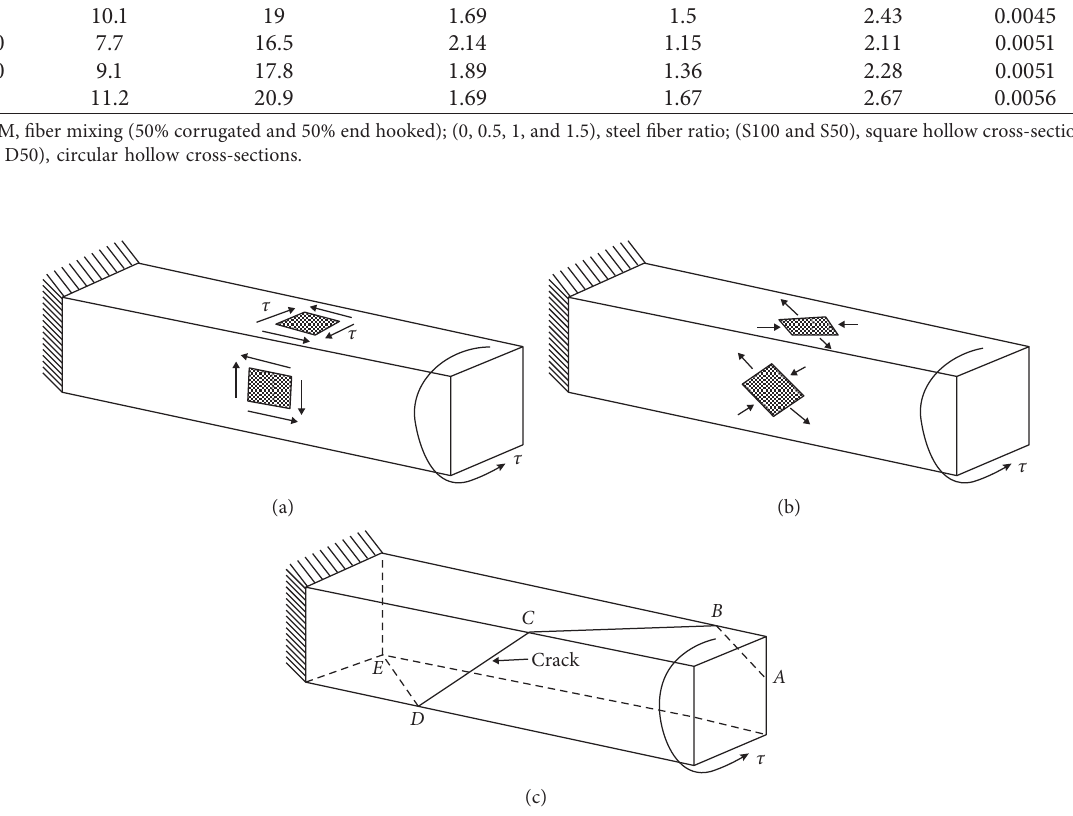
Figure 5: Principal stresses and helical crack patterns due to pure torsion. (a) Shear stresses. (b) Principal stresses. (c) Crack.